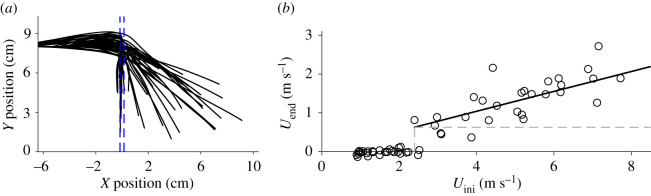
(a) Trajectories of styrofoam balls (N = 59) launched into the waterfall, the position of which is represented by broken lines in blue. (b) Initial ball speed (Uini) versus final speed (Uend) at the end of the trial. Grey broken lines indicate the initial speed at which balls successfully crossed the waterfall (i.e. Uini > 2.3 m s−1). The regression is given by Uend = 2.2 Uini + 2.3 (r2 = 0.56, F1,28 = 35.7, p < 0.001).